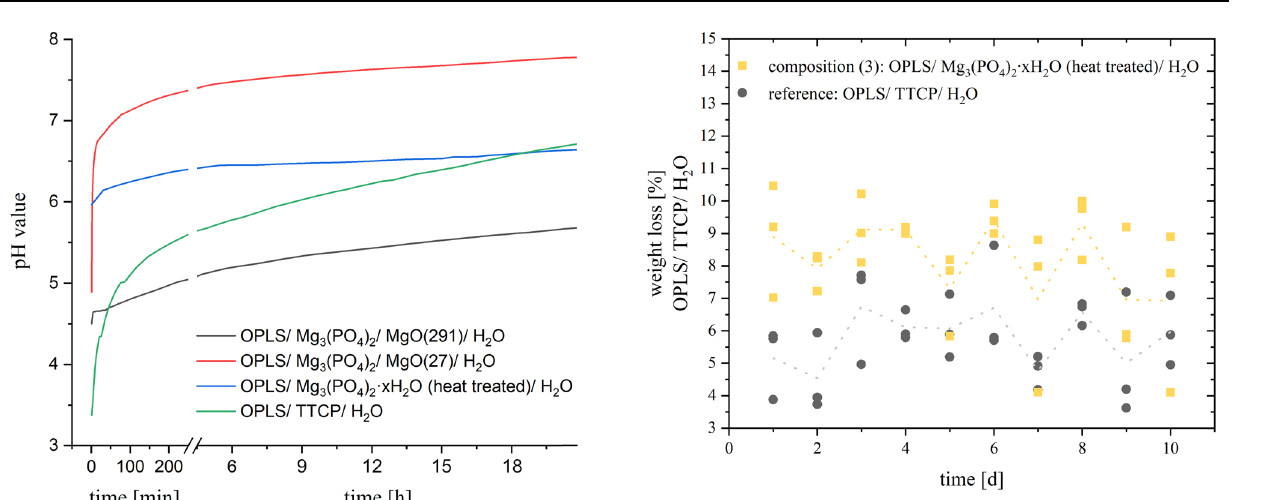
Fig. 7 Weight loss [wt%] of composition (3) (OPLS/ Mg 3 (PO 4 ) 2 ∙ xH 2 O (heat treated)/ H 2 O) and the reference (OPLS/ TTCP/ H 2 O) by storage in PBS over time for 10 days. The dashed line represents the course of the mean